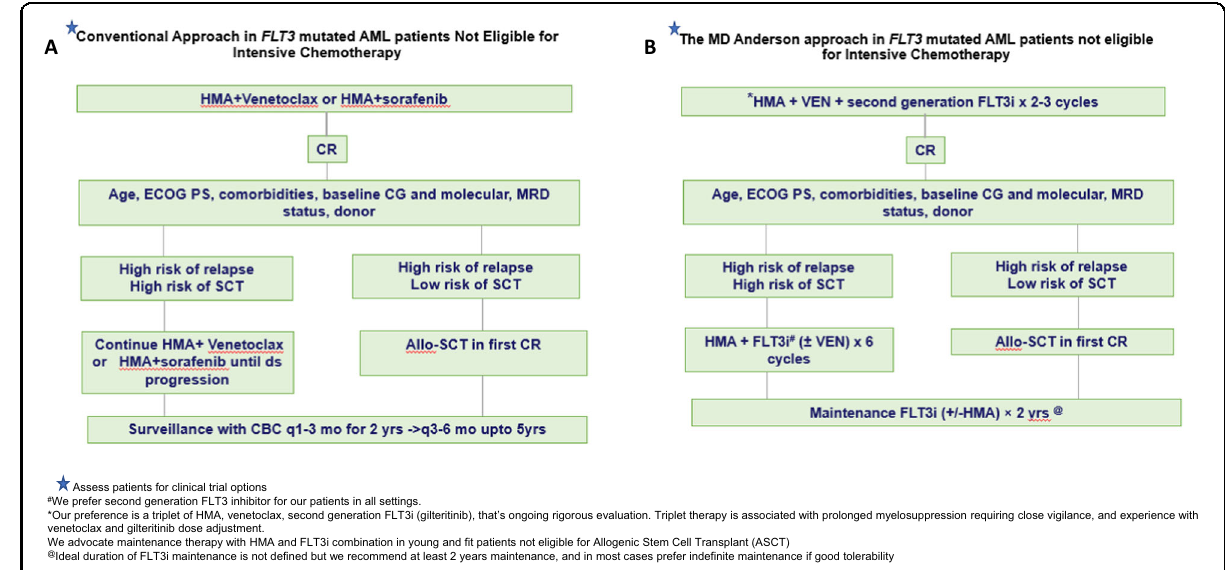
Fig. 2 Treatment algorithm of FLT3 -mutated AML in patients not eligible for intensive chemotherapy. A Conventional approach. B MD Anderson Cancer Center Approach. FLT3i FLT3 inhibitor, HMA hypomethylating agent, VEN venetoclax, CR complete remission, ECOG PS Eastern Cooperative Oncology Group Perfromance Status, CG cytogenetics, MRD measurable residual disease, SCT stem cell transplant, CBC complete blood count.